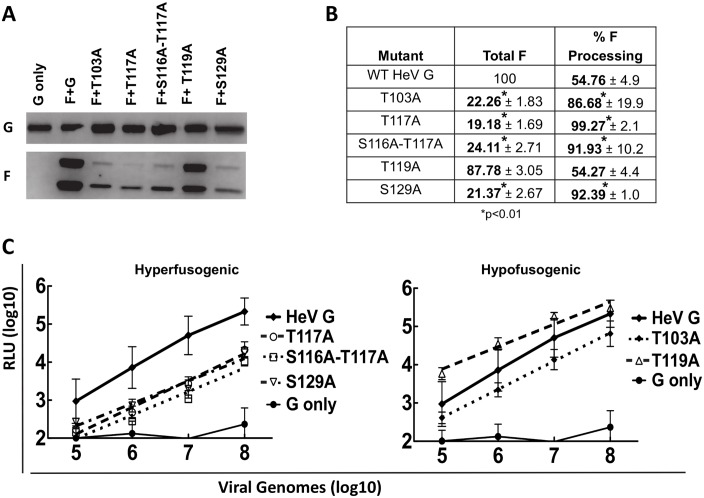
Loss of O-glycans in HeV G affect HeV F incorporation and processing in pseudotyped virions, affecting viral entry.A) Western blot of HeV/VSV viral lysates. HeV G (top panel) and HeV F (bottom panel) were detected as described in Fig 2. B) F incorporation and F processing of the HeV mutant pseudotyped virions determined by densitometry. F incorporation values were normalized to those of wt HeV. F processing was measured by the ratio of F1/ (F0+F1) for HeV pseudotyped virions. N = 3. Statistically significant differences, as determined by a Student’s t-test, are marked with an * (p<0.01). C) Viral entry of HeV/VSV virions at log dilutions of viral input. Values for the mutant virions are compared to wt HeV values. Virions expressing only HeV G (no HeV F) were used as a negative control. Averages and standard deviations are shown. N = 3.